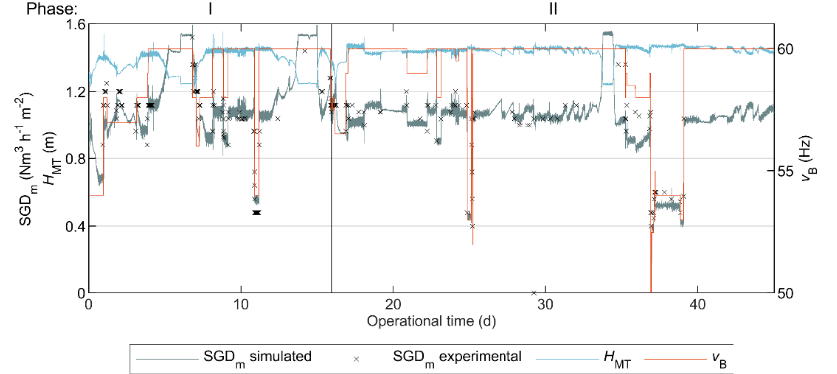
Figure 5. Simulated and experimental specific gas demand (SGD m ), level of liquid in the membrane tank ( H MT ) and motor frequency of the blower ( v B ) during the operational period of the AnMBR dosed with flux enhancer.